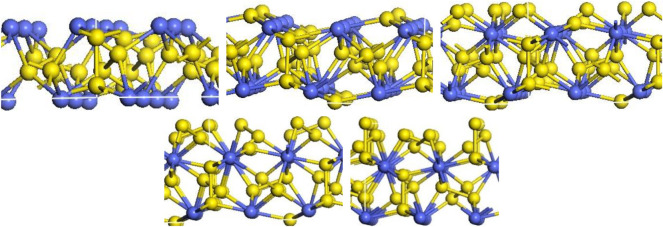
Different terminations of the CoS2 (111) surface. Blue spheres indicate Co atoms and yellow spheres indicate S atoms.